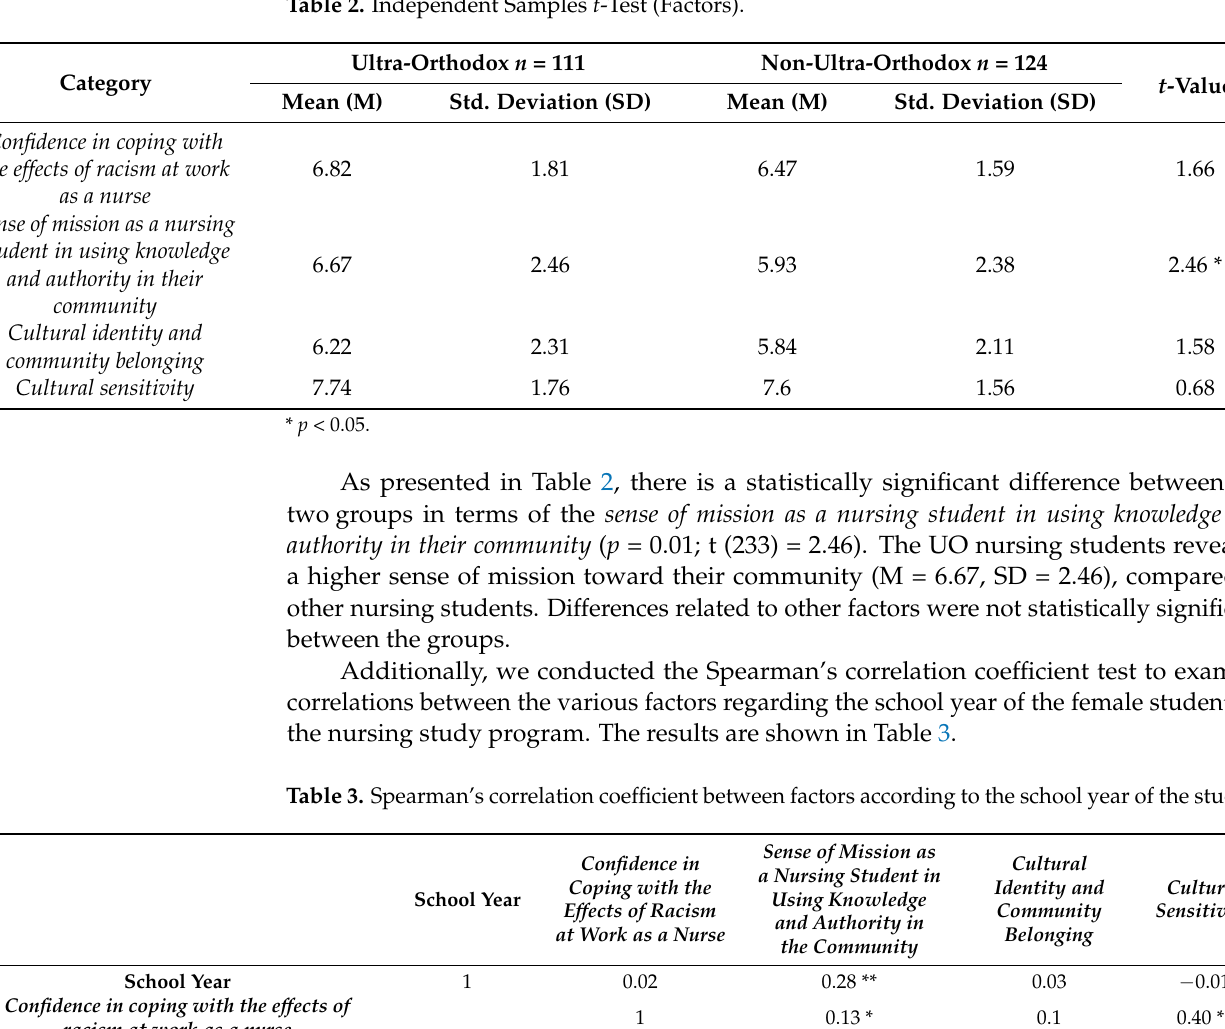
Table 2. Independent Samples t -Test (Factors).